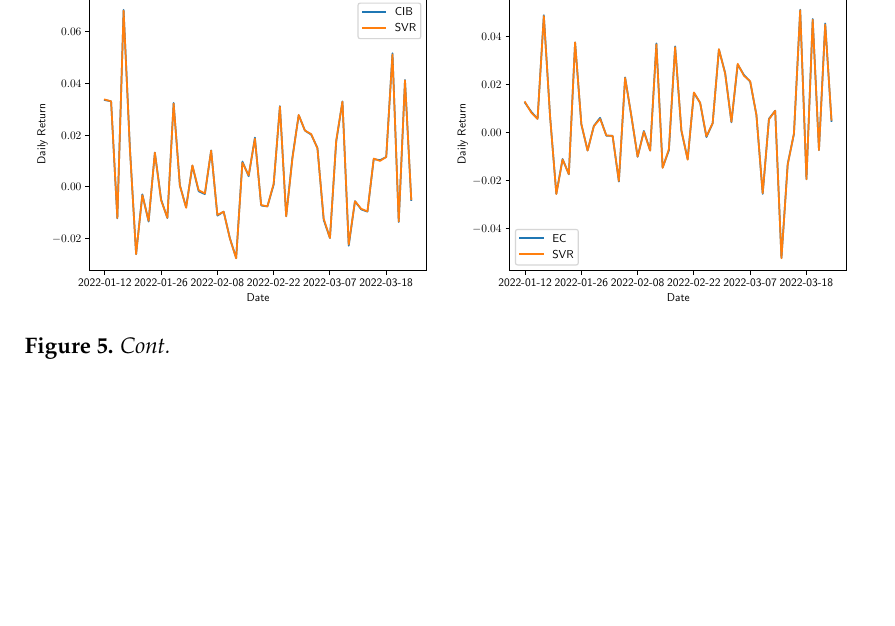
Table 4. MAE, MSE , and R 2 for the cumulative returns forecast using the ARIMA model. The Diebold–Mariano test was used for the prediction pair ( DM , p -value ) columns are multiplied by 10 − 7 .